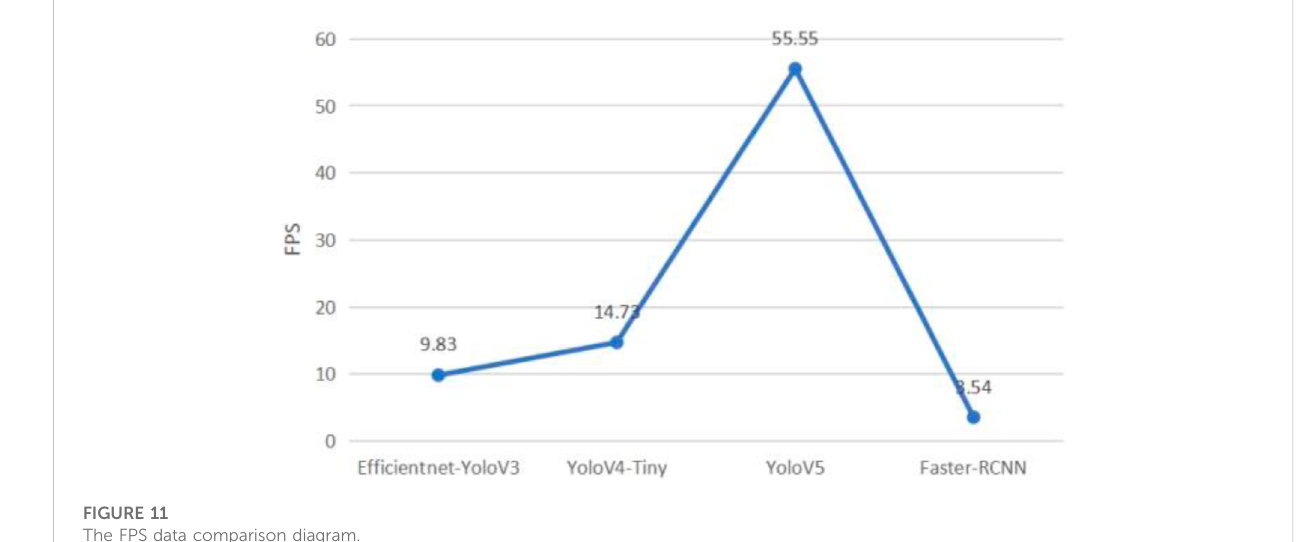
FIGURE 11 The FPS data comparison